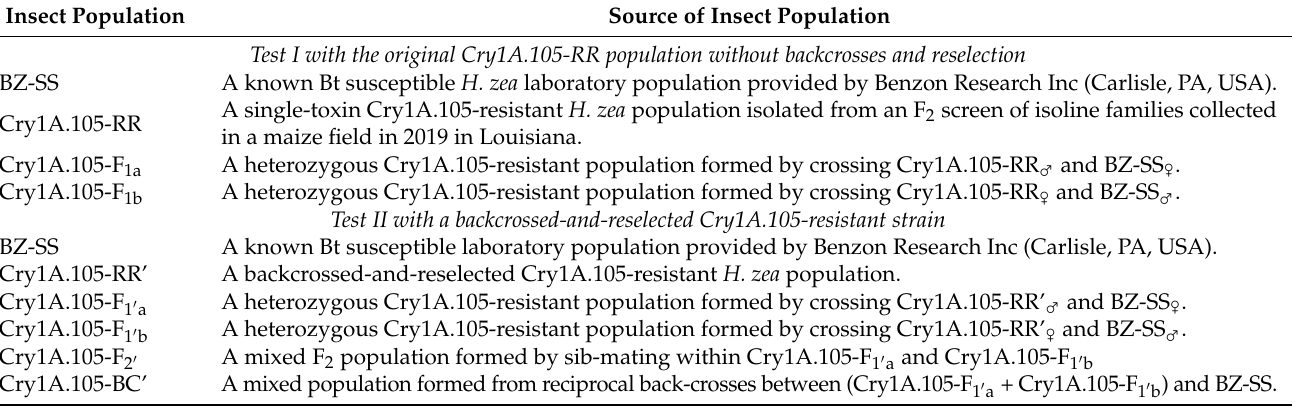
Table 1. Insect populations used in characterizing the inheritance of Cry1A.105 resistance in H. zea . Insect Population Source of Insect